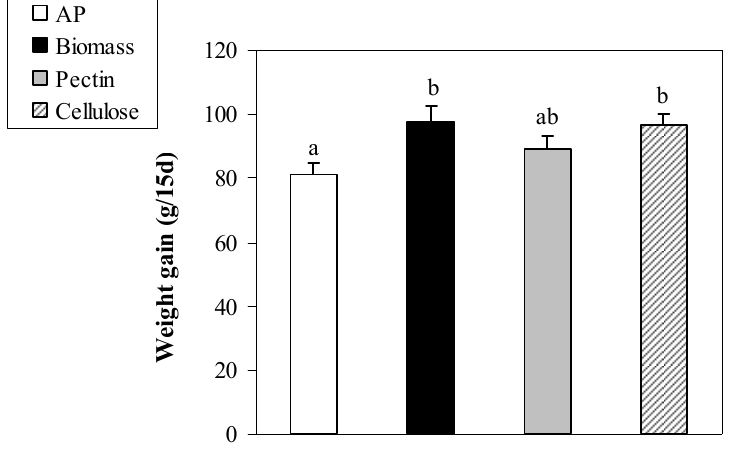
Figure 1. The effect of feeding a hypercholesterolemic diet on weight gain in control rats and rats fed either red microalgal biomass or algal polysaccharide (AP) for 15 days. The isolated fractions contained either soluble polysaccharides found in the growth medium of the algae (AP) or isolated cells (Biomass). Mean values with no common letters were significantly different, p < 0.05. Bars represent